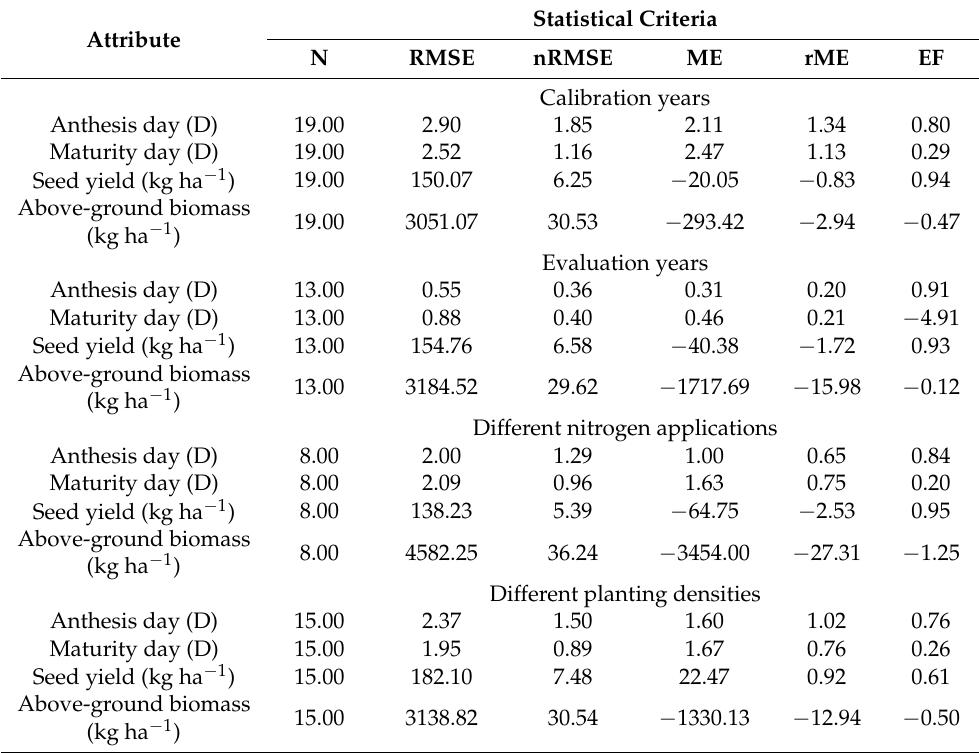
Table 4. Model statistical